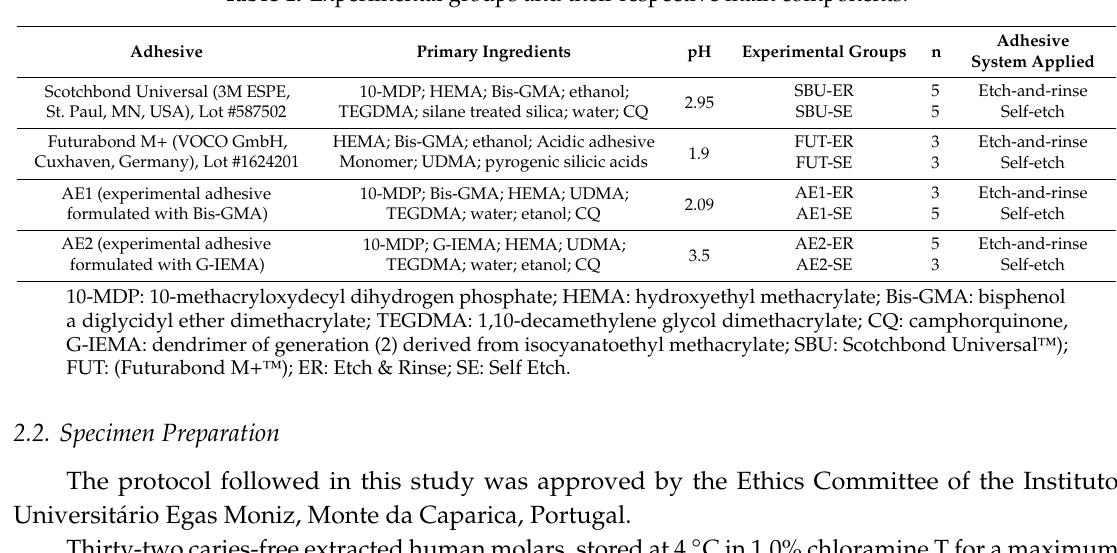
Table 1. Experimental groups and their respective main